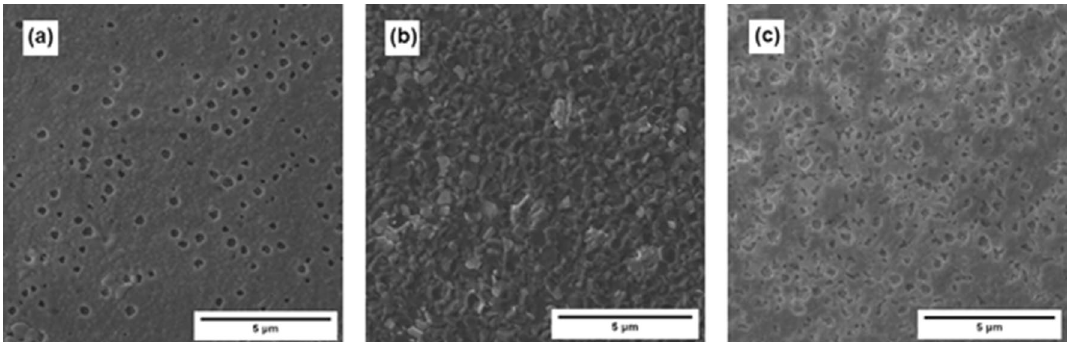
Figure 9. Top-view SEM images of ( a ) as-prepared α-MAPbI 3 , ( b ) post-PCA MAPbI 3 ( c ) post-annealing (non-PCA) MAPbI 3 . Upon simple annealing there is an increase in the grain size, but complete defect healing is observed only upon PCA. The same annealing time was used for ( b , c ), i.e. 80